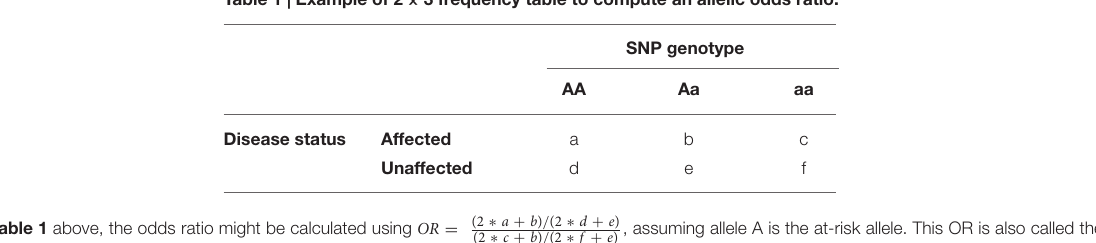
Table 1 | Example of 2 × 3 frequency table to compute an allelic odds